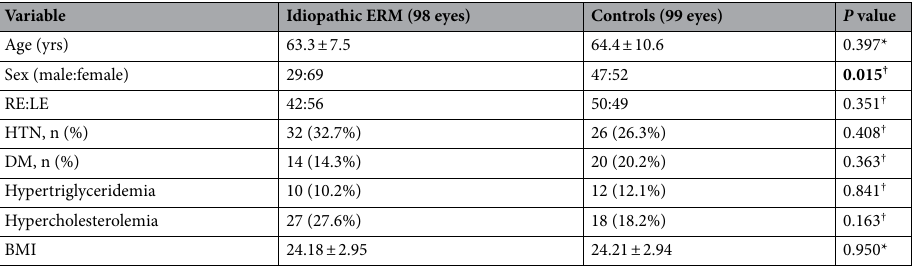
Table 1. Baseline characteristics of patients with epiretinal membrane and normal controls. ERM epiretinal membrane, yrs years, RE right eye, LE left eye, HTN hypertension, DM diabetes mellitus, BMI body mass index. Continuous variables are reported as mean ± standard deviation (range). All other data are numbers. Significant factors appear in boldface. *Student t test. † Chi-square test.